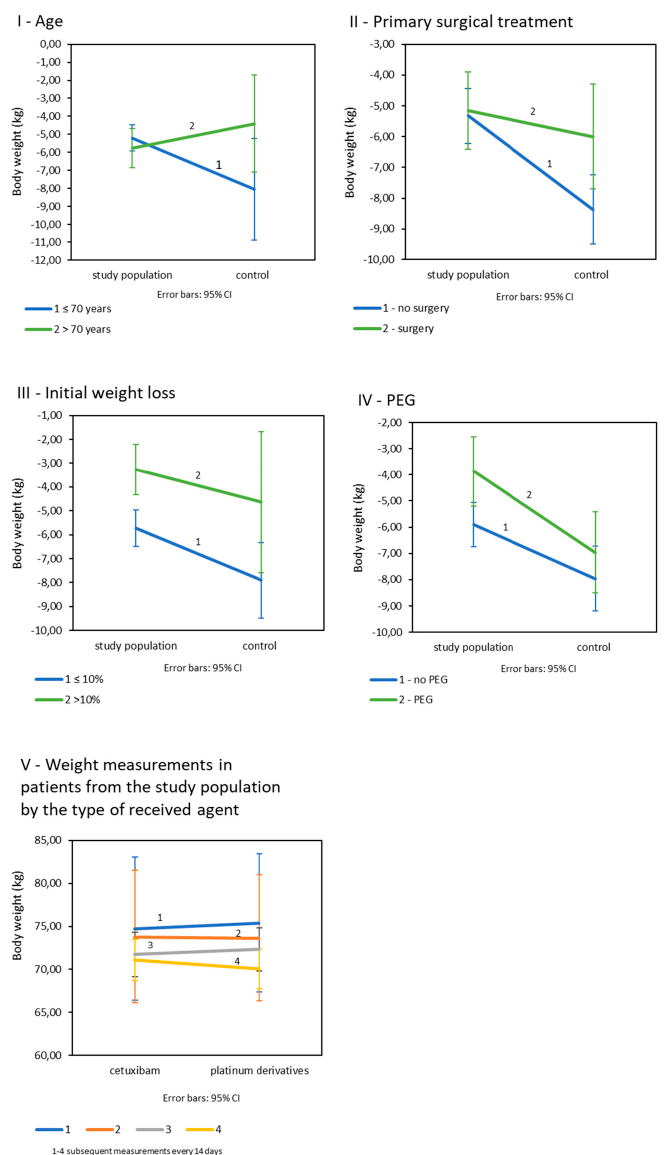
Figure 2. Mean weight loss in study and control populations depending on: ( I ): age; ( II ): primary surgical treatment; ( III ): initial weight loss; ( IV ): prophylactic PEG placement ( V ): mean weight loss in control measurements in patients from the study population by the type of received drug ( n =